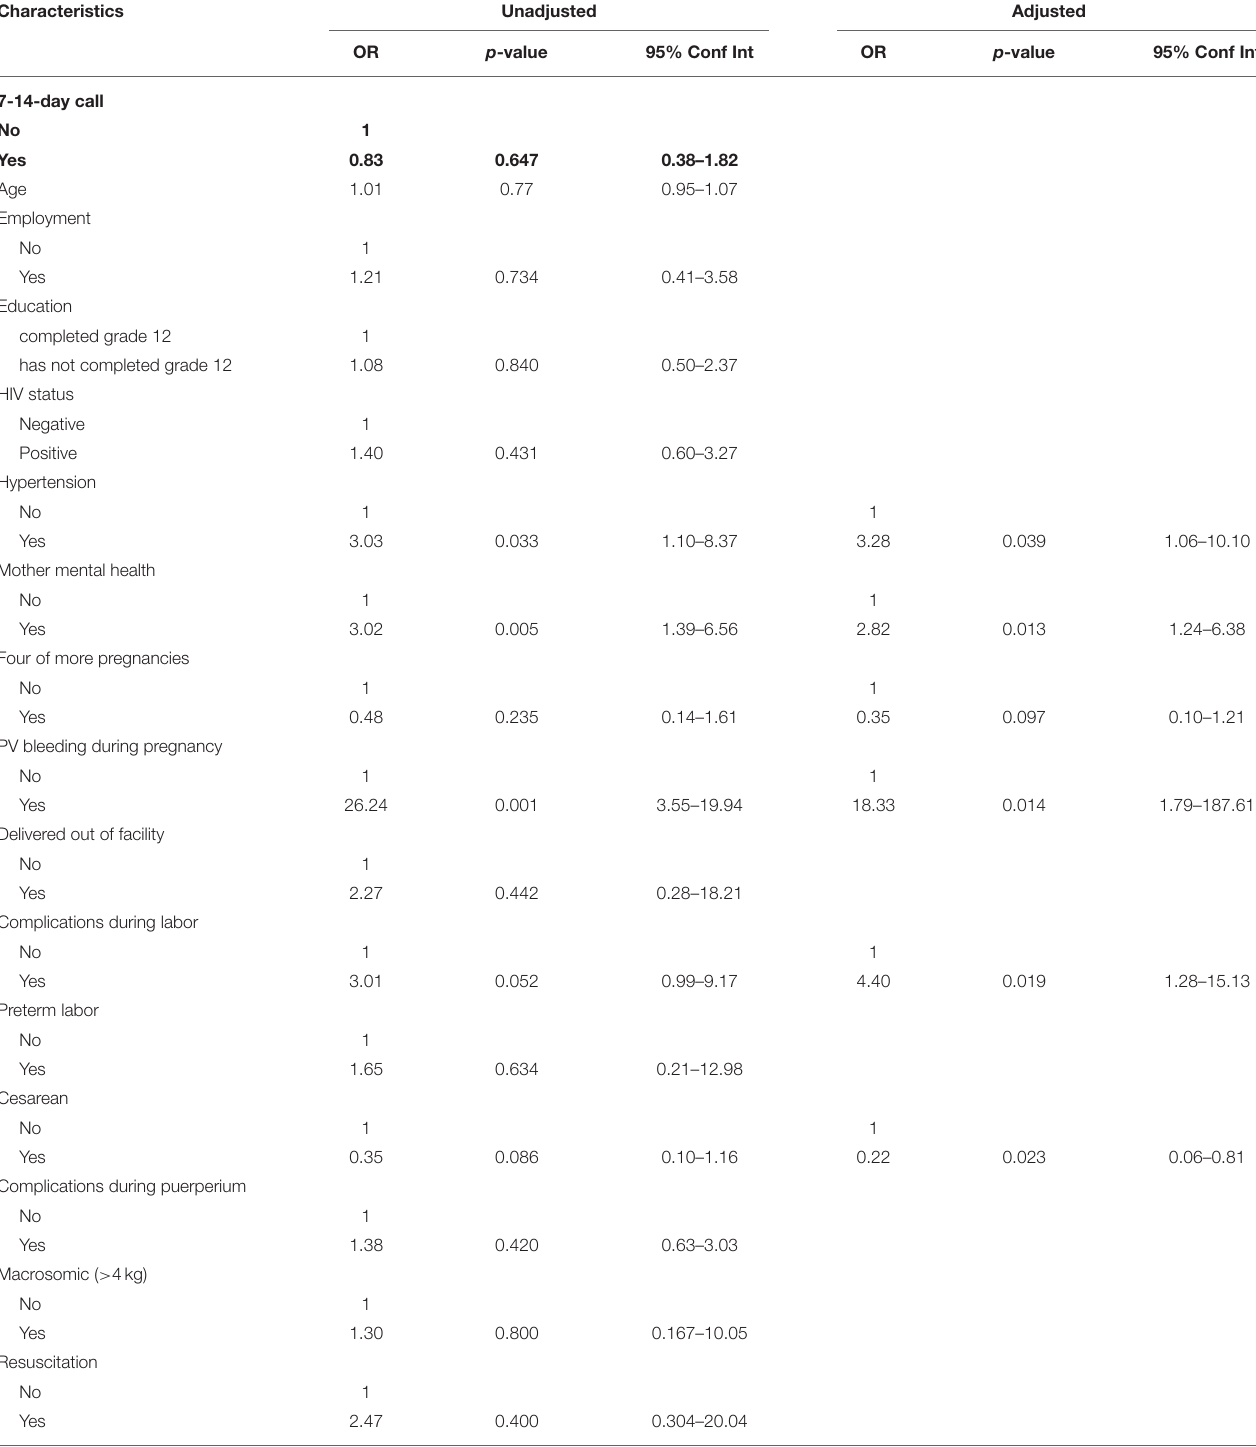
TABLE 2 | Logistic regression of factors associated with access to other health services.